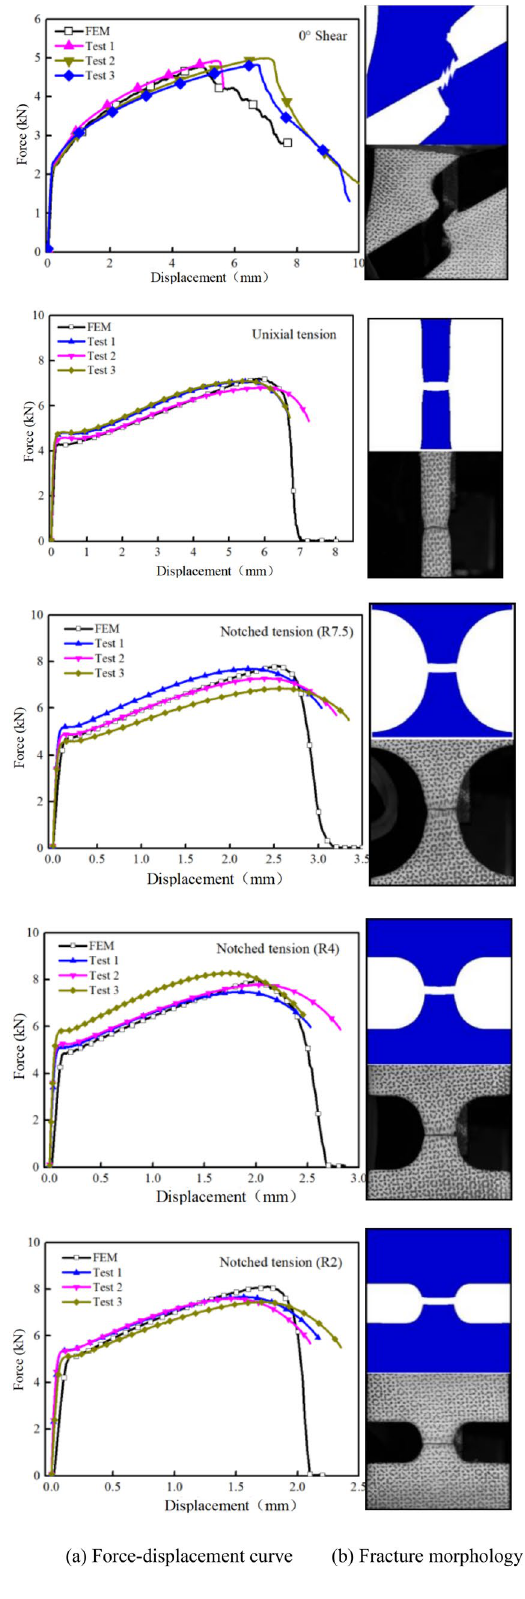
Figure 9 Comparison of test and simulation of perforated